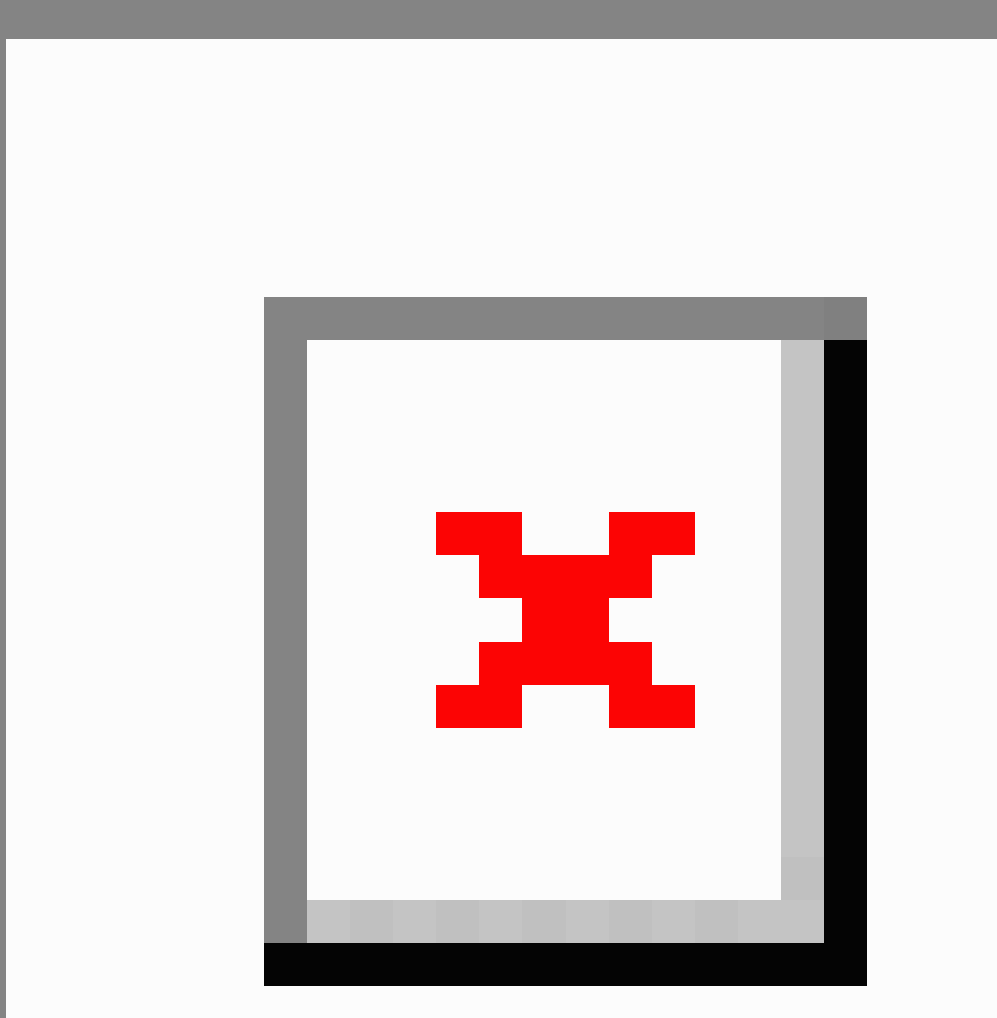
Thorpe et alJMIR MHEALTH AND